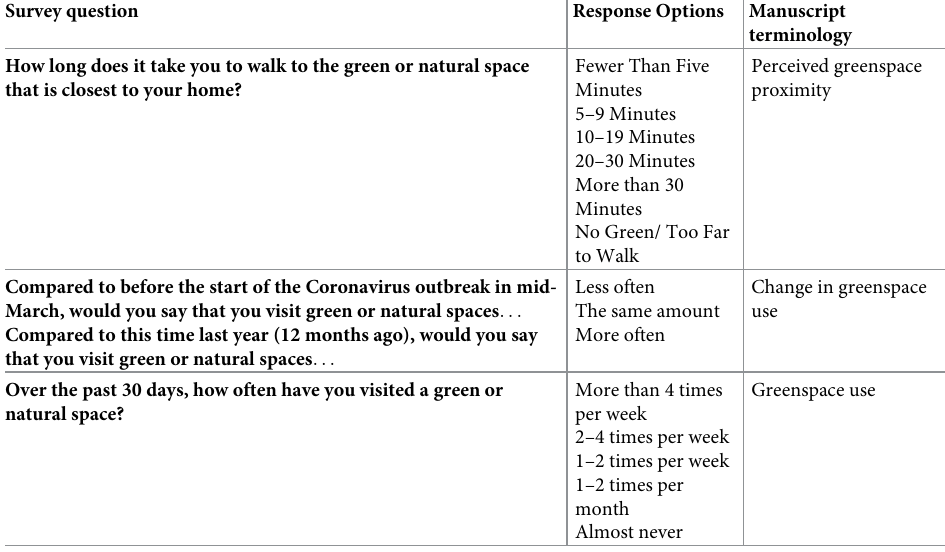
Table 1. Key exposure and outcome